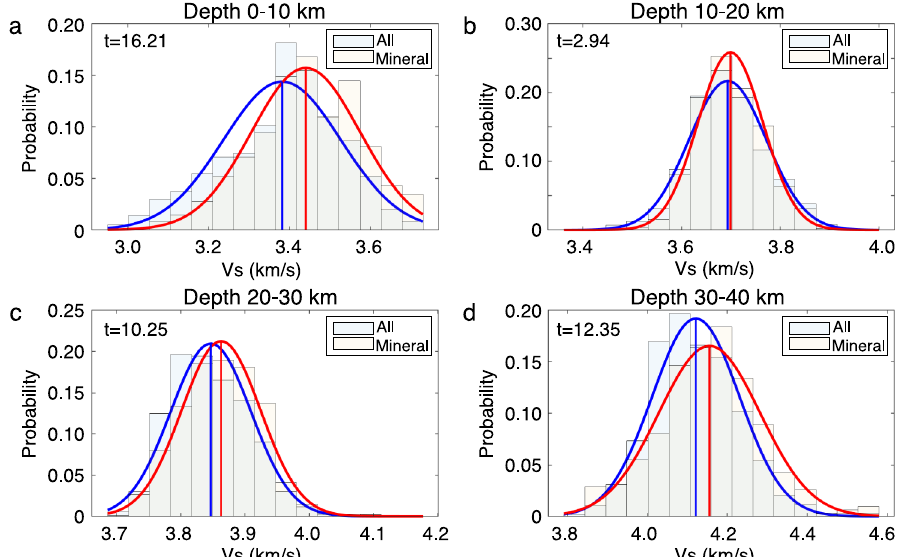
Fig. 8 | Comparison of velocities beneath the mineral deposits and other locations. Seismic velocities are analyzed in the depth ranges of a 0 – 10km, b 10 – 20km, c 20 – 30km,and d 30 – 40km.Thehistogramshowsthedistributionof shear velocity and is normalized. The curves in corresponding colors are the